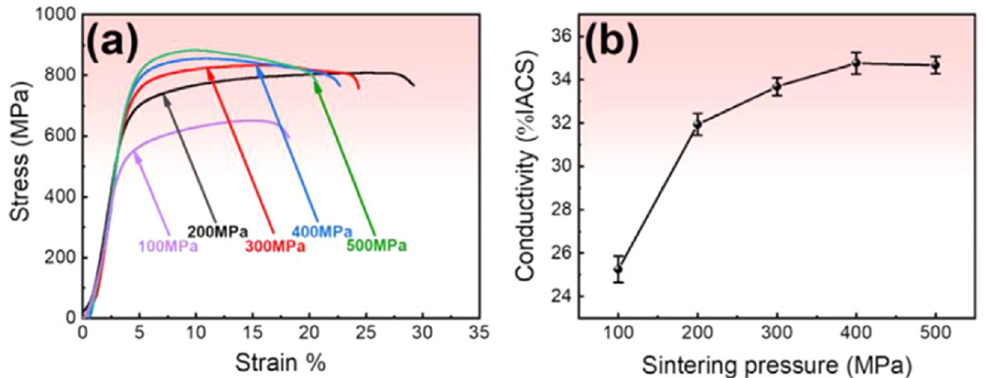
Figure 19. ( a ) Engineering stress–strain curves of composites obtained via SPS of CuCrZr alloy + 24 wt.% Cu 50 Zr 43 Al 7 metallic glass mixtures at 693 K and different pressures; ( b ) variation in the electrical conductivity of the composites with the sintering pressure. Reprinted from [88], Copy ‐ right (2022), with permission from